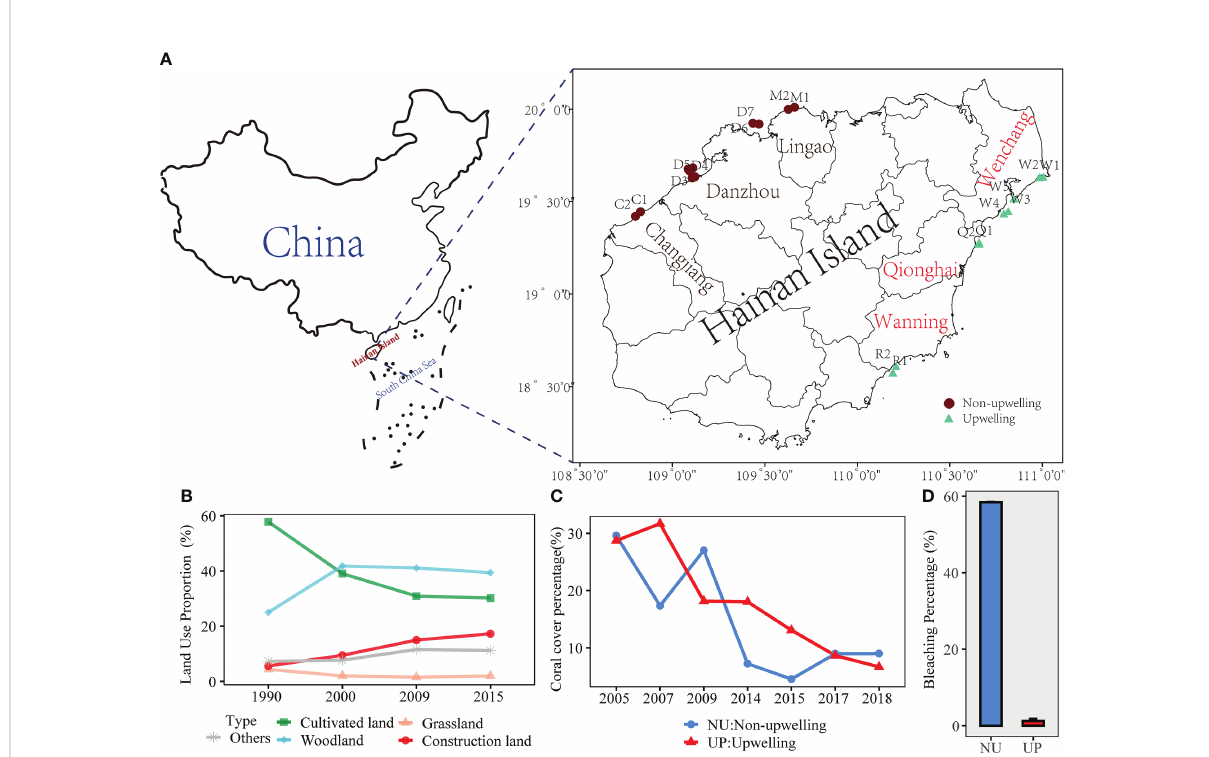
FIGURE 1 Location of survey sites (A) . Change in land use proportion of Hainan Island coastal zone from 1990 to 2015 (B) , and the data was from results by Han (2018). Live reef coral coverage at fi xed stations in the west (non-upwelling stations) and east (upwelling stations) of Hainan Academy of Ocean and Fisheries Sciences (C) , and data was described in a previous study by Huang et al. (2021). The bleaching percentage of northwest coastal areas compared with that of eastern Hainan Island in 2020 (D) , and the results were from Zhu et al. (2021) and Lyu et al.